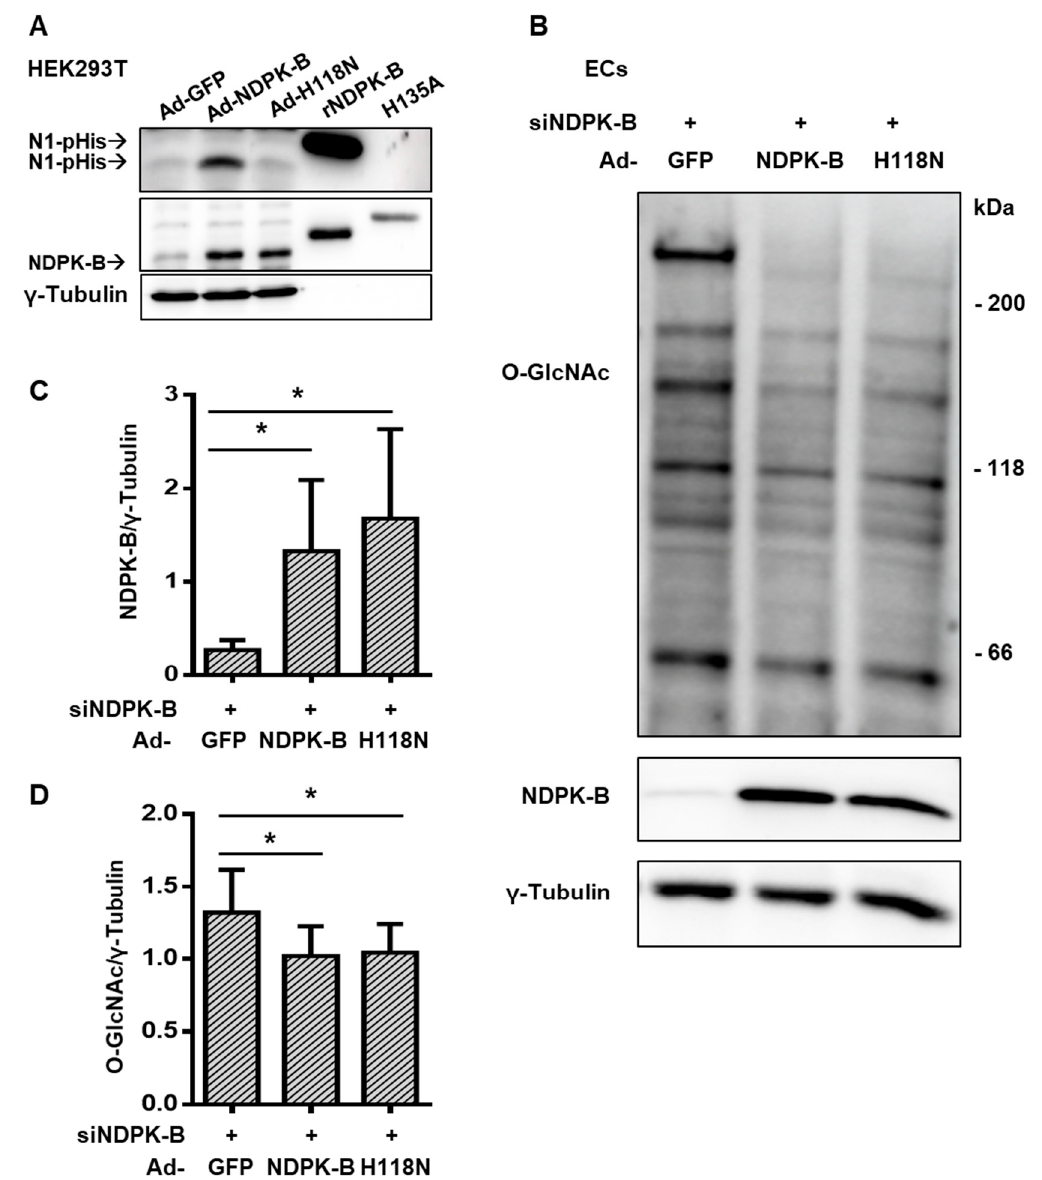
Figure 6. Regulation of protein O-GlcNAcylation is independent of the enzymatic NTP / NDP transphosphorylase and protein histidine activity of NDPK-B kinase. ( A ) HEK293T cells were transduced with adenoviruses expressing GFP (Ad-GFP), NDPK-B (Ad-NDPK-B), or enzymatically inactive mutant NDPK-B H118N (Ad-H118N). Cell lysates were analyzed for N1-phosphohistidine, NDPK-B, and γ -tubulin content by immunoblot. Recombinant NDPK-B (rNDPK-B with 6 × His-Tag) and a recombinant, enzymatically inactive mutant NDPK-C (H135A with 6 × His-Tag) were used as positive and negative controls, respectively, for NDPK autophosphorylation. ( B ) HUVECs were transfected with siRNA against NDPK-B (siNDPK-B, + ) and then infected with adenoviruses expressing either GFP (Ad-GFP), NDPK-B (Ad-NDPK-B), or NDPK-B H118N (Ad-H118N). NDPK-B and protein O-GlcNAcylation were analyzed by immunoblot (n = 8). Quantification of ( C ) NDPK-B and ( D ) protein O-GlcNAcylation relative to γ -tubulin. Results are presented as mean ± SD. *: p <